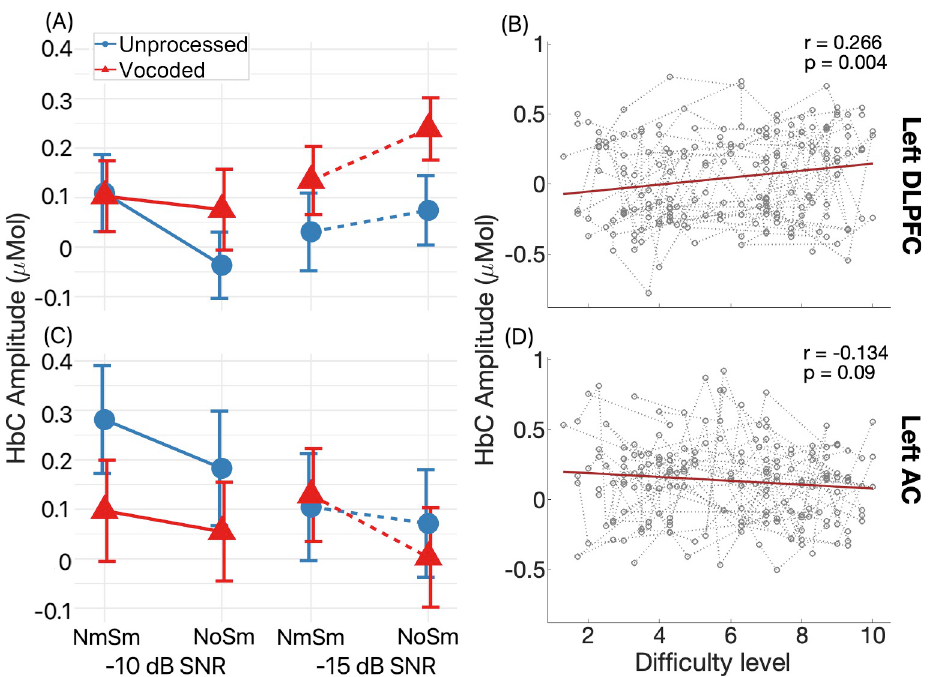
Fig 6. Δ HbC amplitudes in the left DLPFC and AC. Panels A and C show the group mean (bars) and SEM (error bars) of Δ HbC amplitudes in the left DLPFC and AC, respectively, in the unprocessed (blue dots) and vocoded (red triangles) speech conditions with monaural (N m S m ) and diotic noise (N o S m ) at -10 dB (solid lines) and -15 dB SNR (dash lines). Panels (B) and (D) show the repeated measures correlations (rmcorr) between Δ HbC amplitudes in the left DLPFC and AC, respectively, and self-reported task difficulty level. In each panel, the gray dash lines connecting circles represent measures in individuals in different conditions; the red lines indicate the regression result from the rmcorr